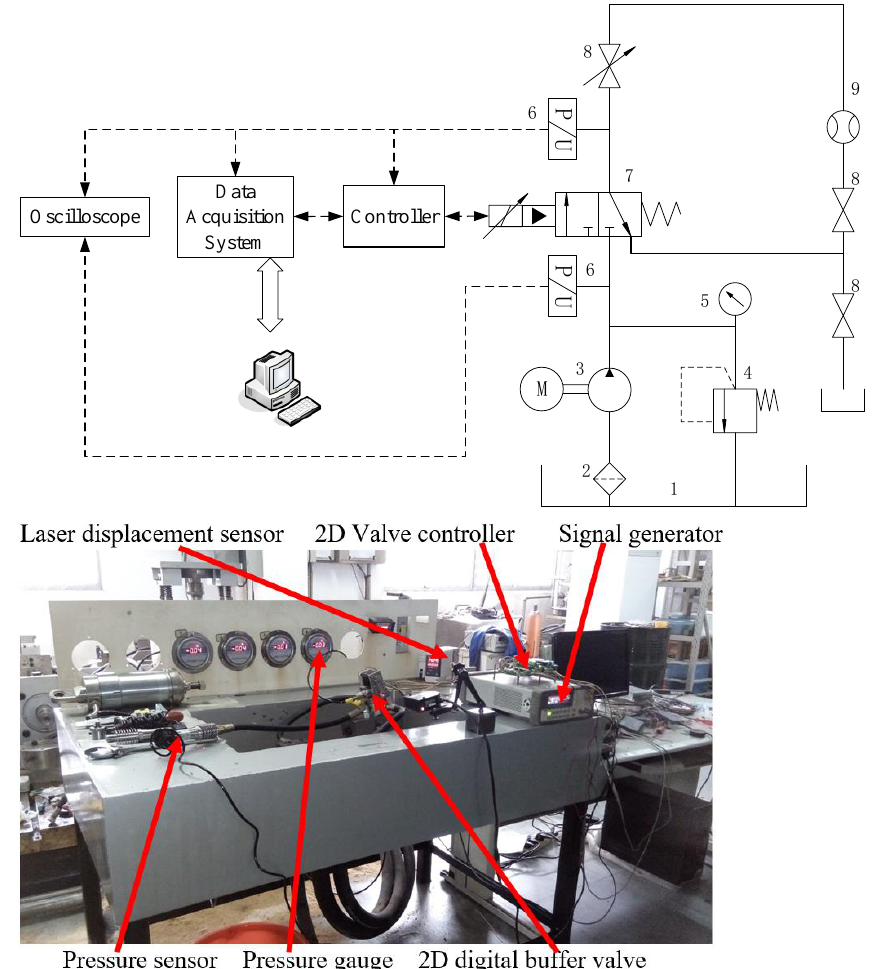
Figure 7. The 2D digital buffer valve buffer characteristics test platform. 1: tank; 2: filter; 3: pump; 4: relief valve; 5: pressure gauge; 6: pressure sensor; 7: 2D digital buffer valve; 8: globe valve; 9: flowmeter.